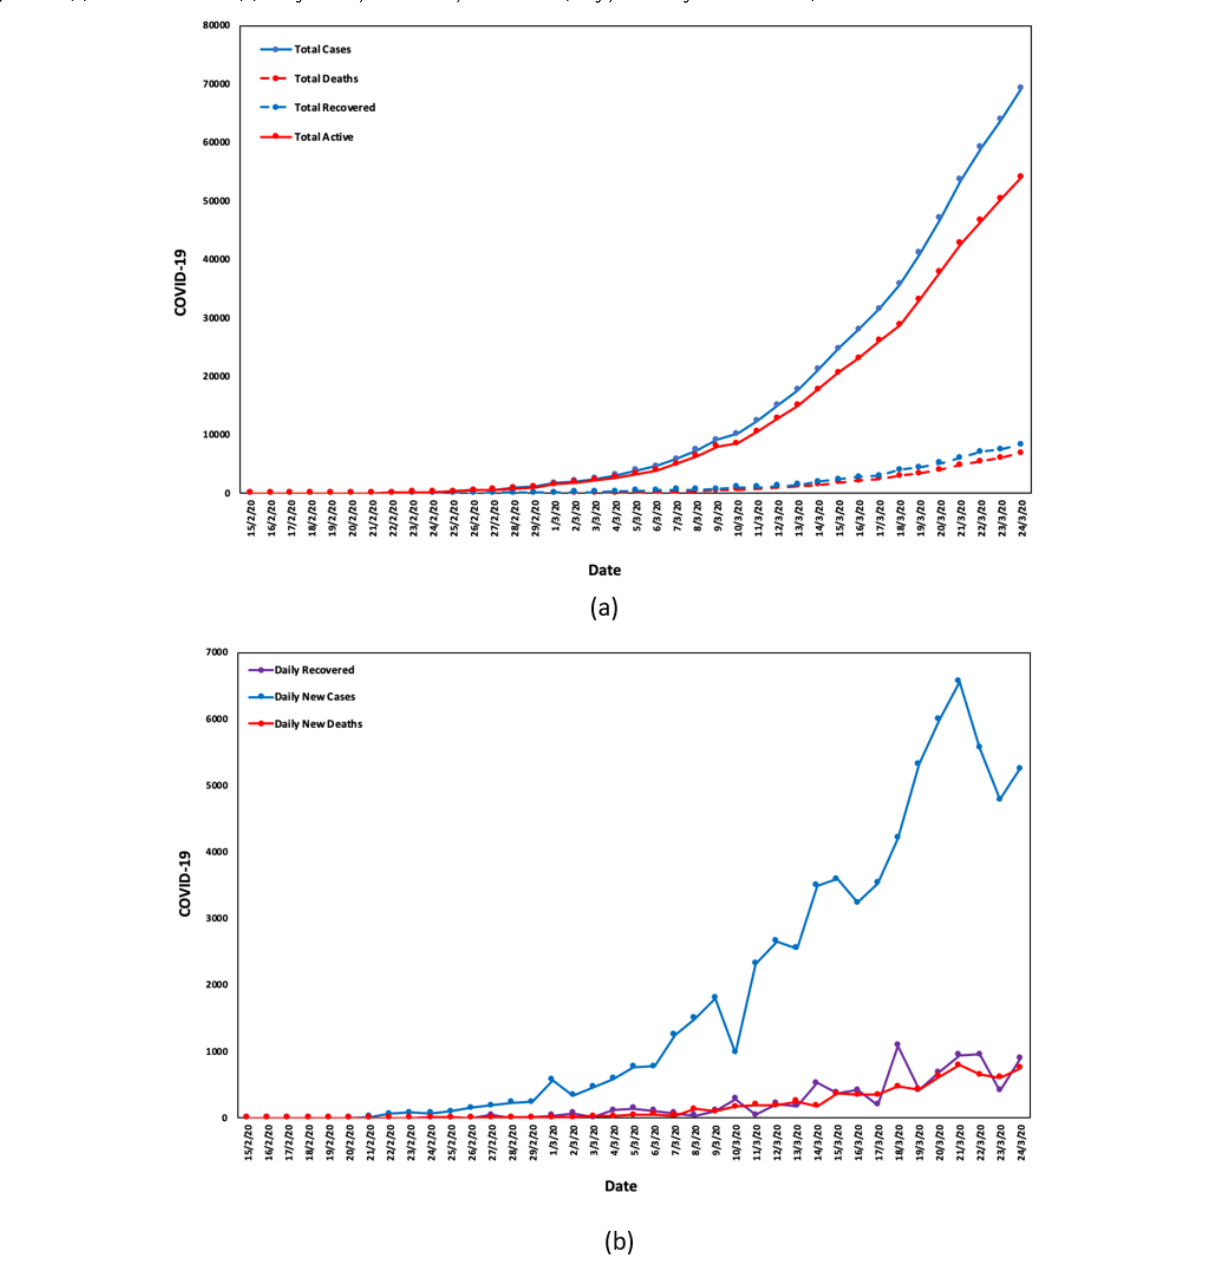
Table 2 consists of the correlations between Google Trends data and cases, deaths, daily new cases, and daily new deaths in Italy for the aforementioned time frames. Tables 3-4 consist of the individual regions’ correlations between COVID-19 cases and Google